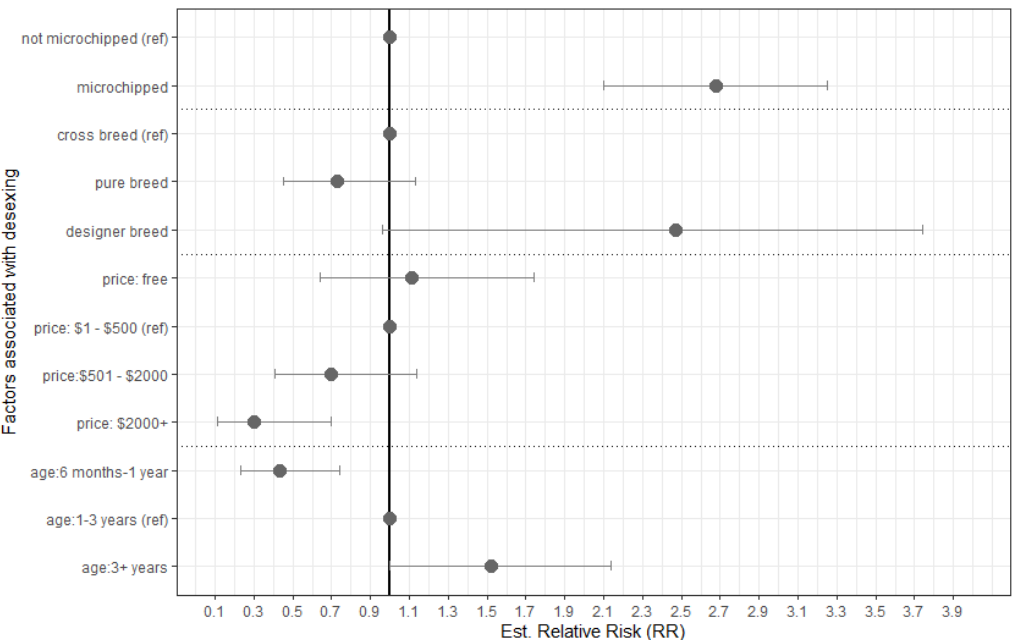
Figure 2. Estimated relative risks for predictors associated with dogs being desexed at time of sale in 499 unique online dog and puppy advertisements posted on Gumtree, webscraped on two separate days (25 March and 8 April 2019) as found through multivariable logistic regression model. Predictors remaining were statistically significant to p < 0.005. Dataset only includes dogs over 6 months of age.